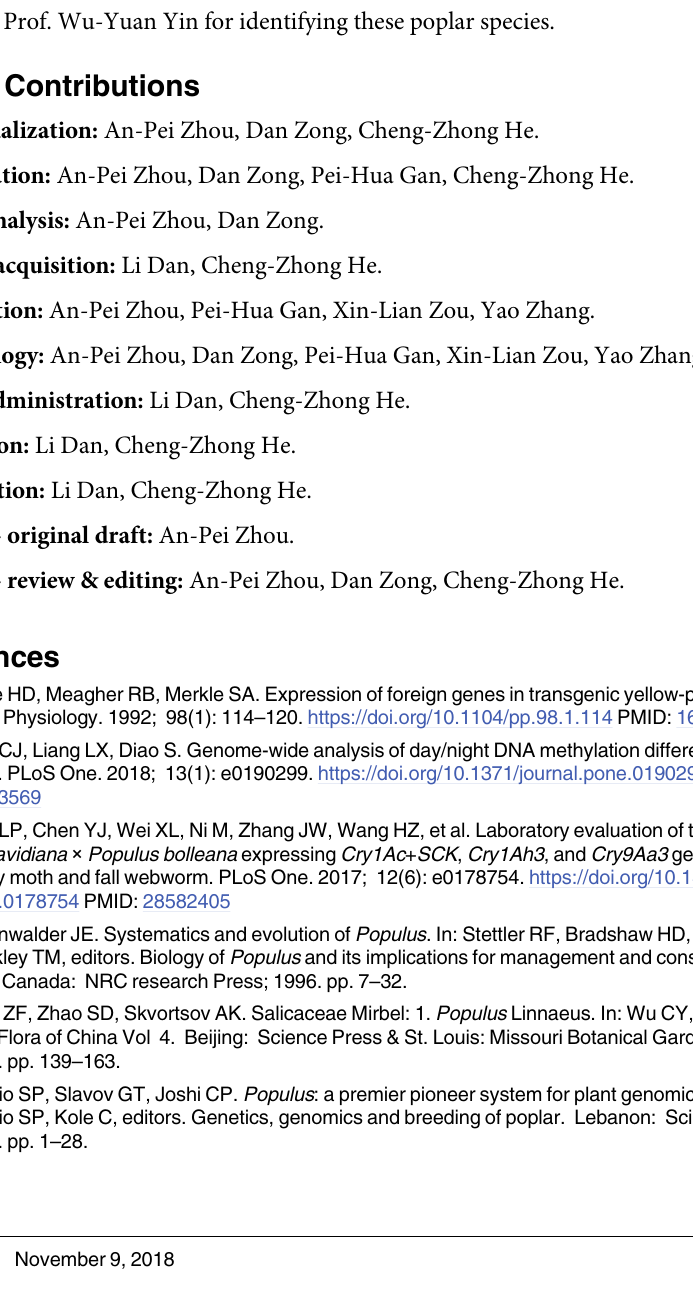
S1 Table. Source of Populus . S2 Table. List of primers used in this